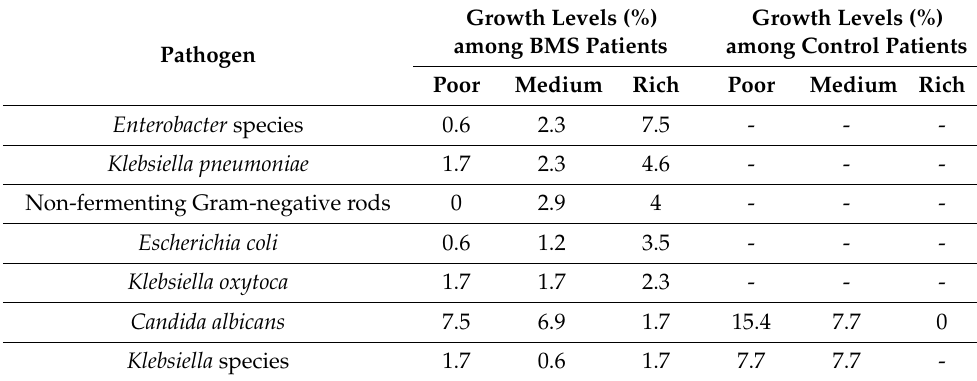
Patients with Enterobacter, Klebsiella pneumoniae , and non-fermenting Gram-negative rods had the highest number of cases with rich pathogen growth levels, as shown in Table 2. Table 2. Growth levels as a percentage (%) among infected BMS